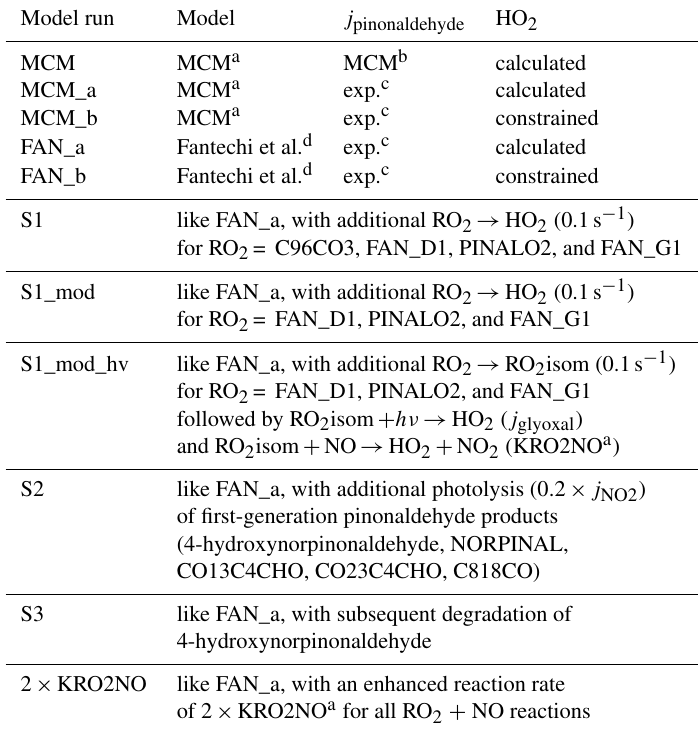
Table 2. Overview of different model calculations. Model run Model j pinonaldehyde